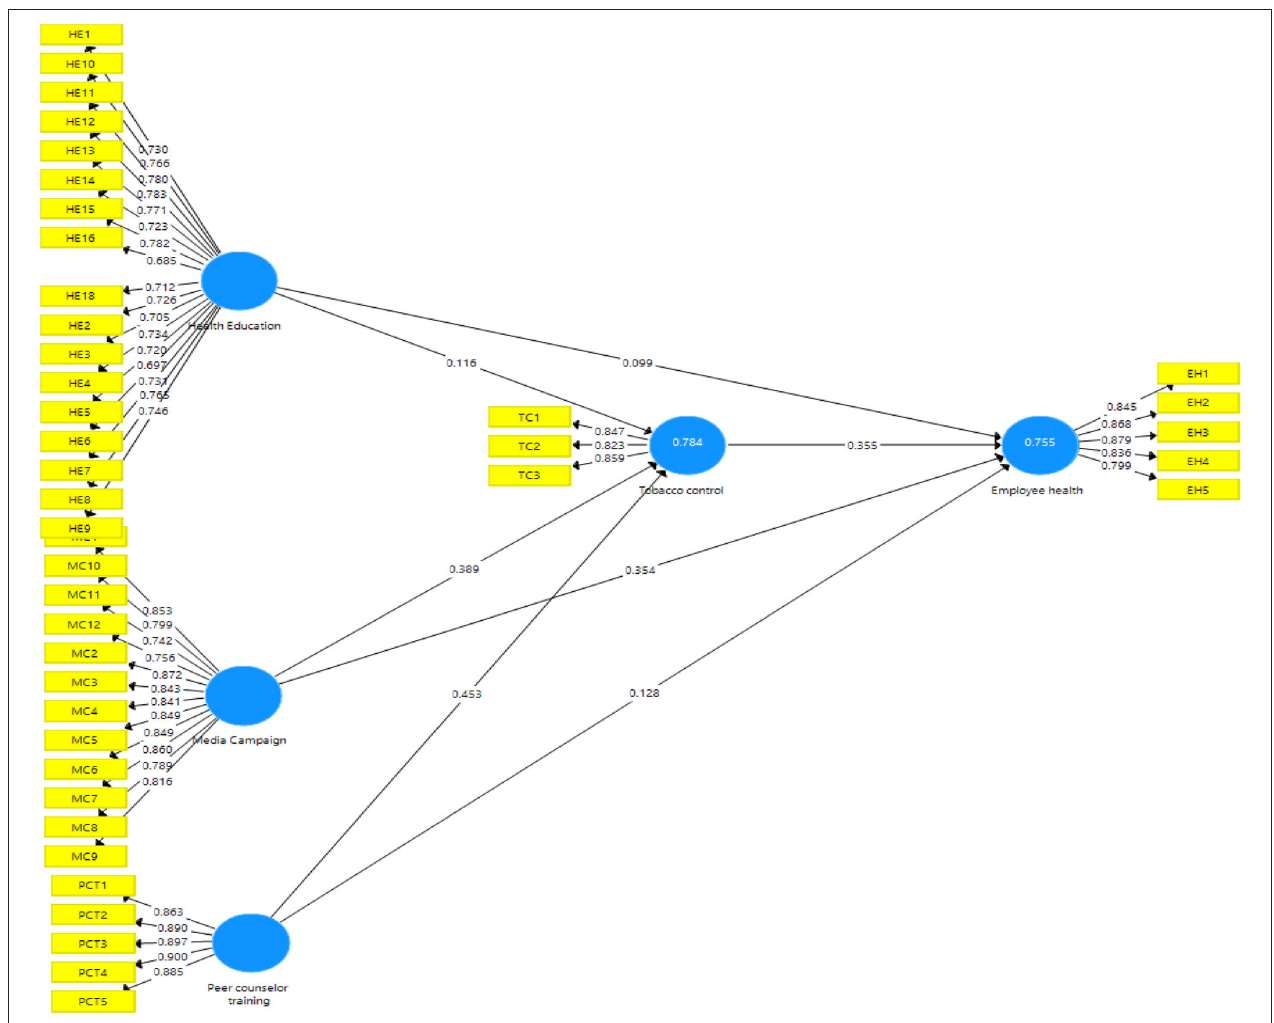
FIGURE 2 | Measurement